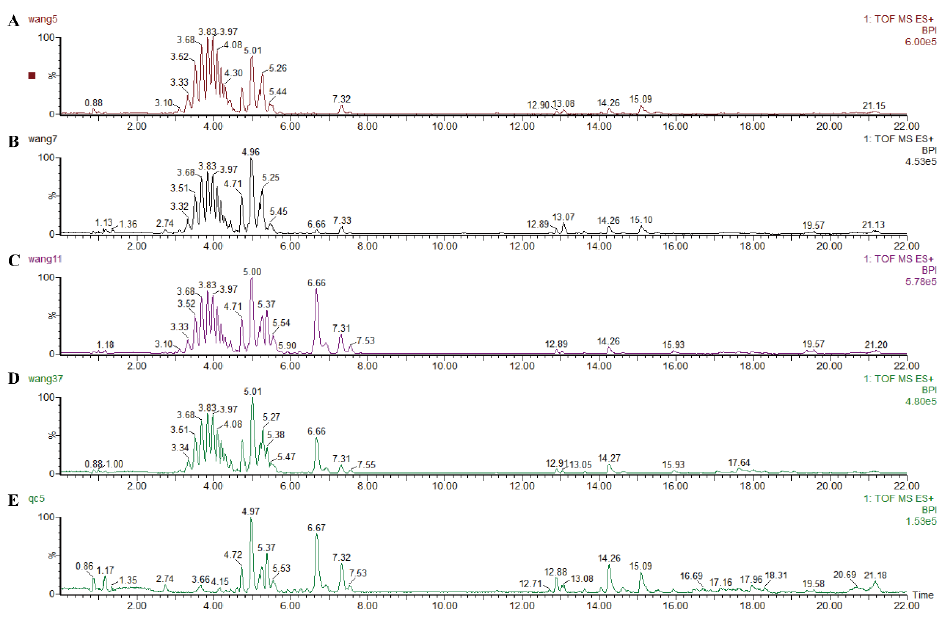
Figure 3. Typical BPI of feces samples in positive ESI mode. ( A ) Control group; ( B ) CCl 4 -induced liver fibrosis group; ( C ) CCl 4 + TACS group; ( D ) CCl 4 + COL group; ( E ) QC (quality control).